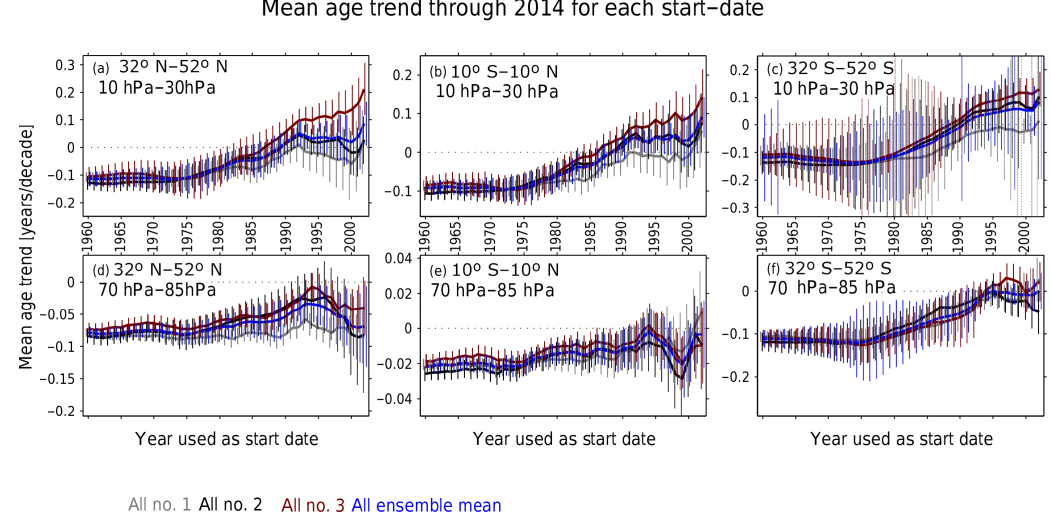
Figure 3. Trend through 2014 in annual averaged mean age in the NH (left), tropics (middle), and SH (right) for start dates starting in 1960 and ending in 2002. Each line is for one member of the all-forcing ensemble or for the all-forcing ensemble mean. Changes in the mid- stratosphere (deep branch) are shown in (a–c) , and changes in the lower stratosphere (shallow branch) are shown in (d–f) . 95% confidence intervals on the calculated trends are indicated; note that in the SH mid-stratosphere the correction of Santer et al. (2008) for the number of degrees of freedom leads to very few degrees of freedom for the trend and therefore to high